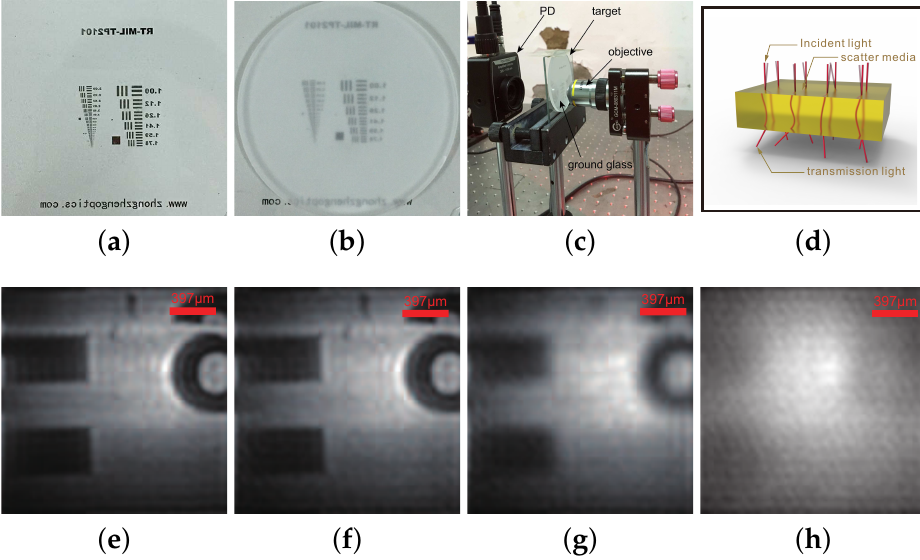
Figure 6. ( a ) The target to be recovered. ( b ) The ground glass diffuser. ( c ) The photograph of the optical structure. ( d ) The scatter model of the ground glass diffuser. ( e ) Image of the target without the scattering media. ( f ) Image of the target when the scattering media was between the target and the photodetector (PD). ( g ) Image of the target when the 1 mm thickness scattering media was between the target and the objective. ( h ) Image of the target when the 2 mm thickness scattering media was between the target and the objective.